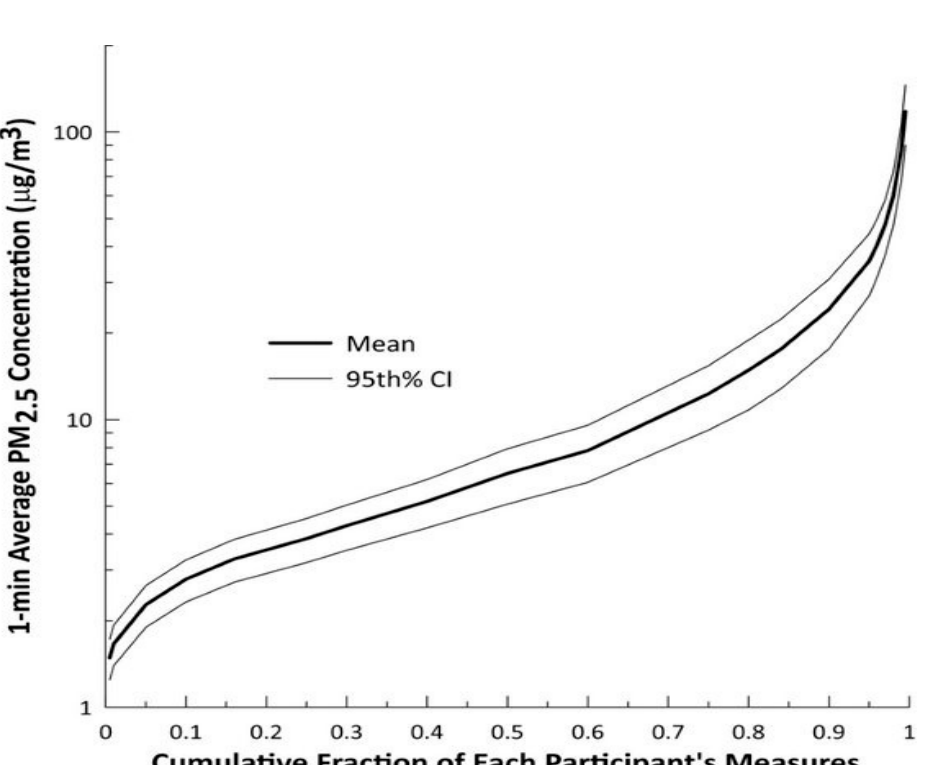
Figure 4. Cumulative distribution of each participant’s 1-min average PM 2.5 concentrations. The 95th percent confidence intervals illustrate the spread in PM 2.5 concentrations across each of the 240 valid nephelometer data files.